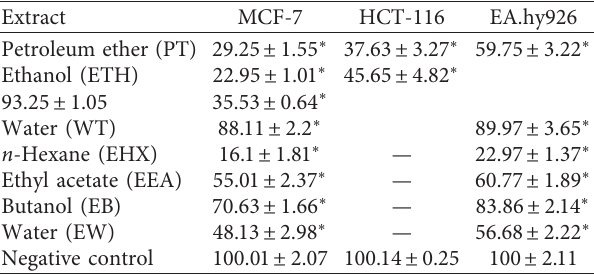
Table 1: Percentage of cell viability by using MTT assay at a concentration 100 μ